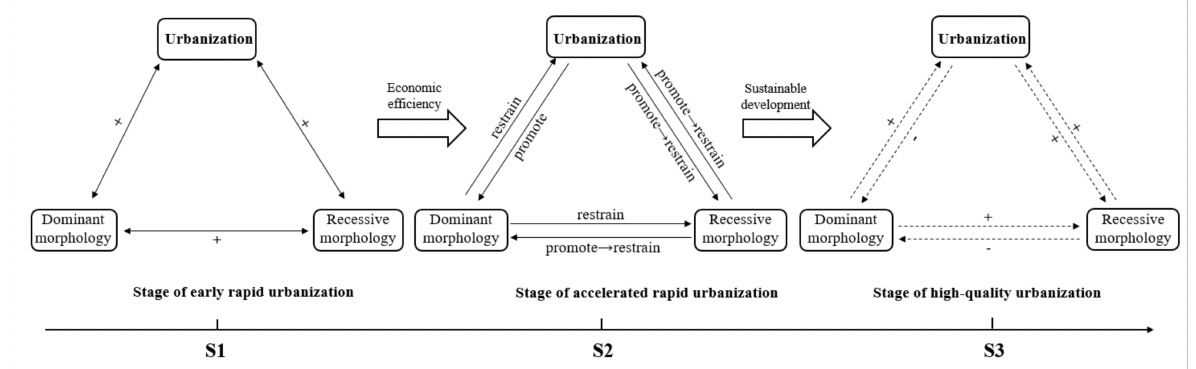
Figure 7. The bidirectional interactive response relationship between urbanization and land-use